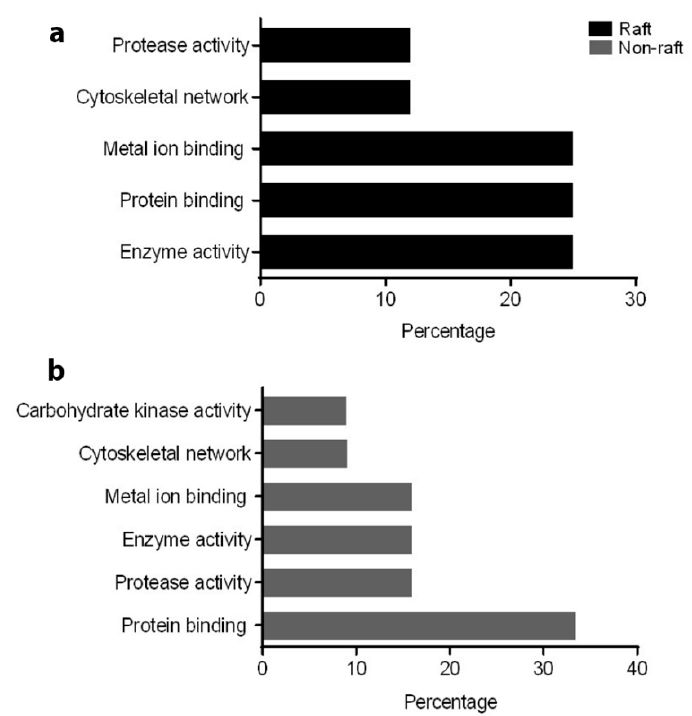
Figure 2. Percentage contribution of molecular functions of differentially interacted proteins in ( a ) raft and ( b ) non-raft membrane fractions.